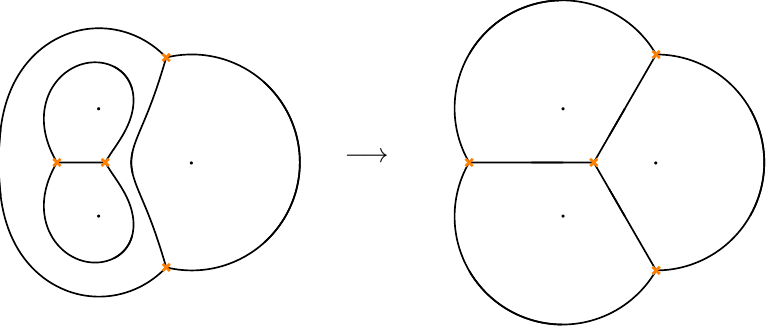
Figure 22. Left: the N f = 4 Strebel graph obtained at # = 0 from M a;b = 3 ; M b;c = 1 : 2, and u = 4 : 3. One can clearly view it as a T 2 where we glued another T 2 in place of one puncture. Tuning moduli eventually brings it into the form shown on the right (which is the BPS graph in the left frame in (cid:12)gure